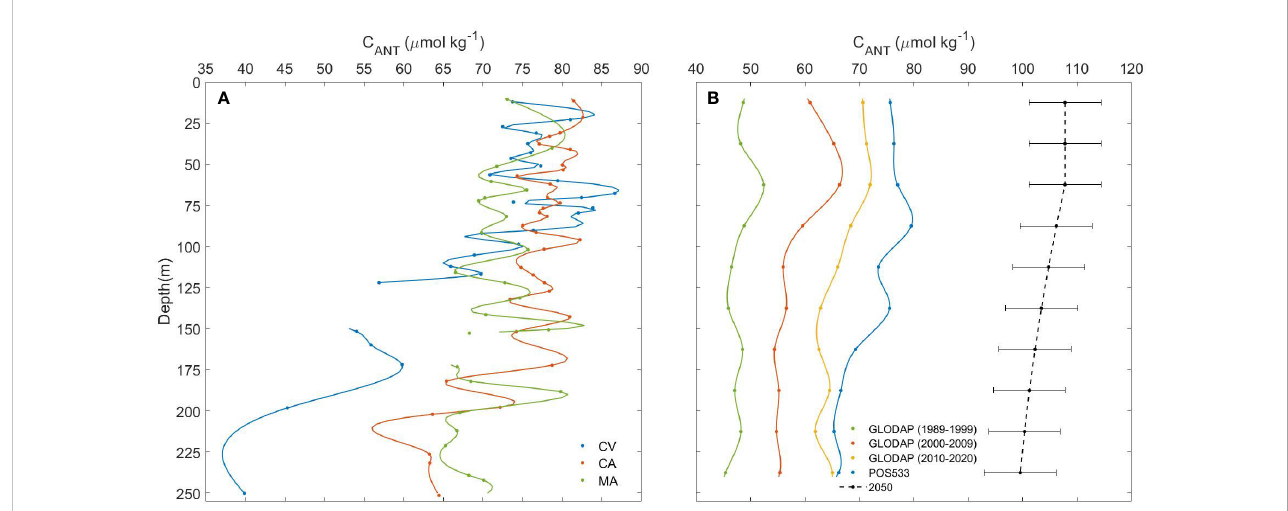
FIGURE 7 (A) Vertical upper-ocean pro fi les (10-250 m depth) of C ant in CV (blue), CA (orange) and MA (green) given by a smoothing spline (smoothing parameter: p=0.999) applied to the total of C ant values calculated from POS533 data in each archipelago. Due to the high quantity of C ant data at several depth levels, only average data per ±4 m depth were plotted as marker points. (B) Vertical upper-ocean distribution (10-250 m depth) of average C ant values in the entire Macaronesia region based on GLODAP data for the decades 1989-1999 (green), 2000-2009 (orange) and 2010-2020 (yellow). The vertical pro fi les of average C ant based on GLODAP data for these three decades were plotted together with average C ant values for the three archipelagos of study during POS533 (blue) for the three archipelagos. The GLODAP and POS533 datasets were compilated to estimate the C ant for the year 2050 (black dotted line) by using Eq. 11 with a standard error of estimate of 6.60 µmol kg -1 . All the average C ant values, its standard deviation and the estimated values for the year 2050 at each level depth are shown in Supplementary Table